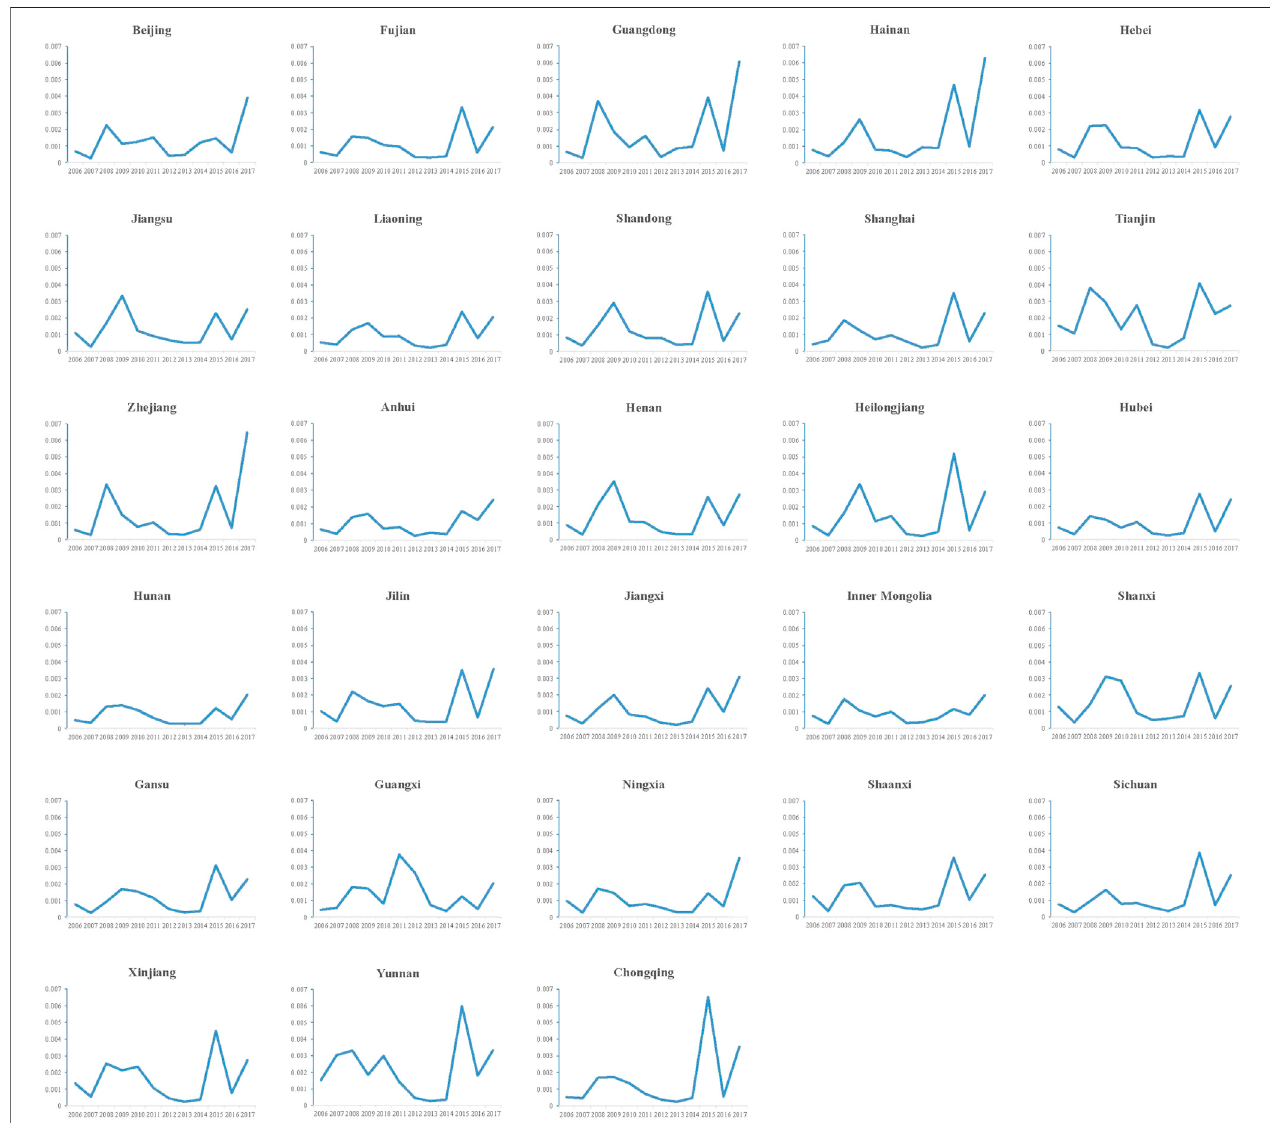
FIGURE 7 | Time trend of market segmentation index in different